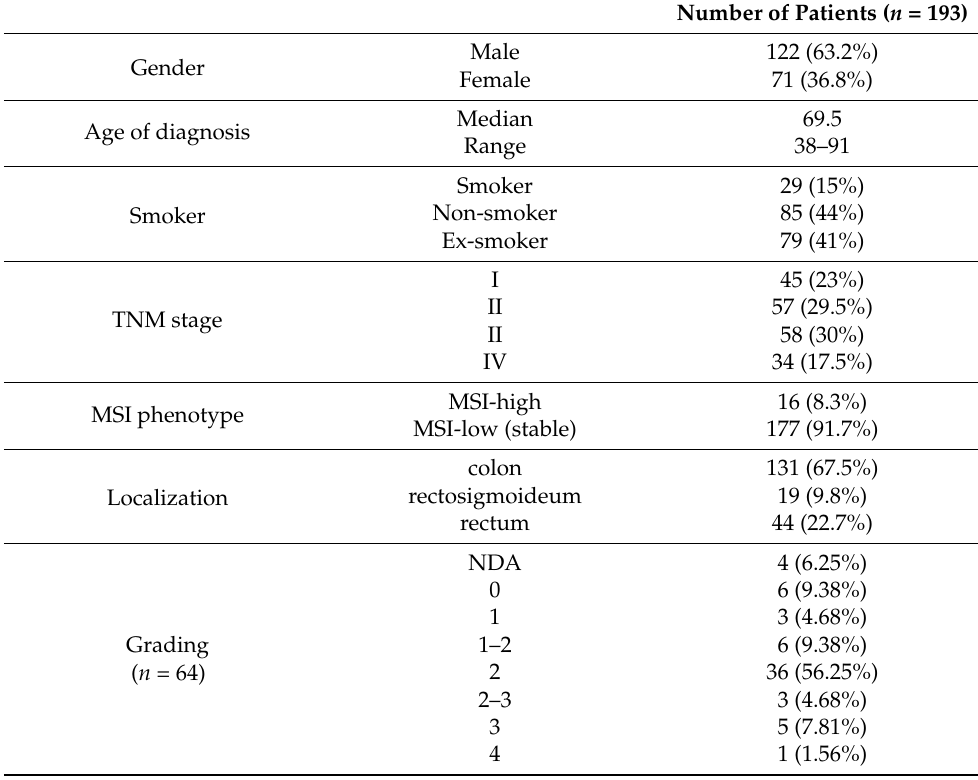
Table 1. Characteristics of the studied